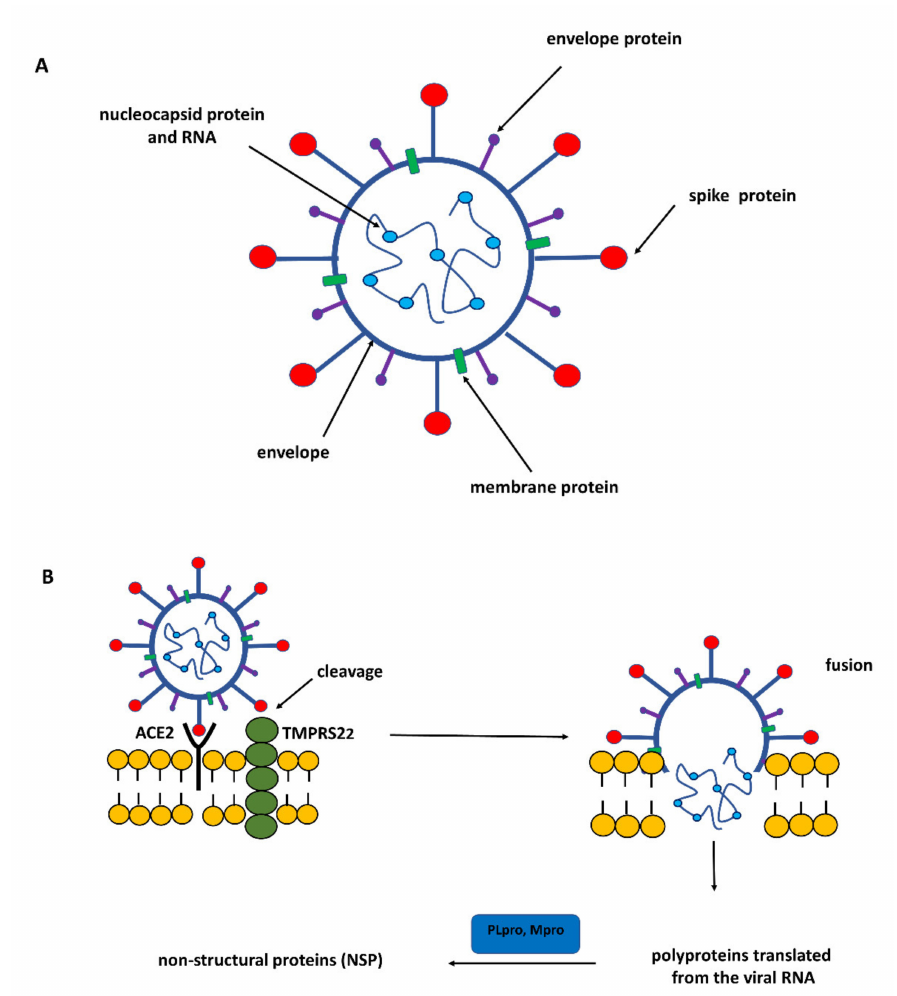
Figure 1. ( A ) Schematic representation of the structure of SARS-CoV-2. ( B ) The infection of the host cell by SARS-CoV-2. TMPRSS2—a transmembrane serine protease 2 that cleaves a dimer of subunits S1/S2 of spike protein making it possible to recognize the angiotensin-converting enzyme 2 (ACE2) receptor on host cells. After fusion of the virus with the host cell, 3-chymotrypsin-like protease called main protease (Mpro) and papain-like protease (PLpro) play a pivotal role in mediating the virus’ replication and transcription by cleaving polyproteins translated from the viral RNA to non-structural proteins (NSP) that are crucial for genome replication and coronavirus virion